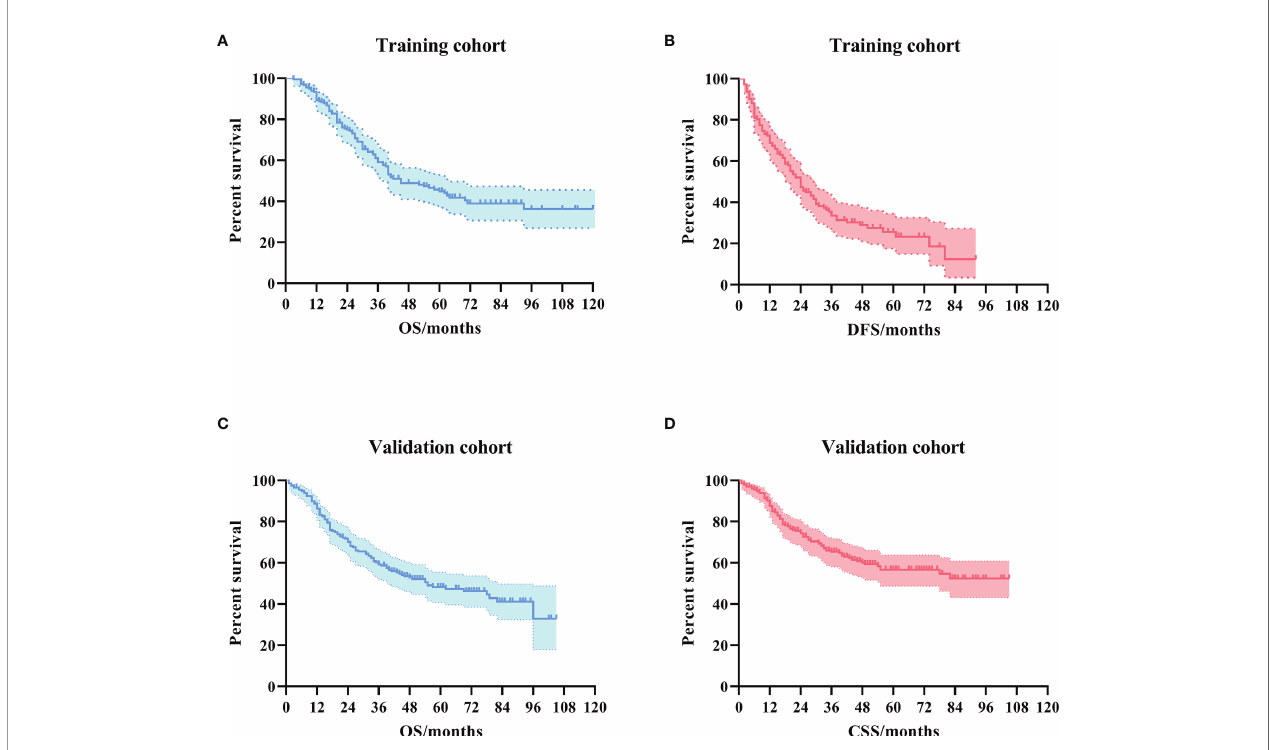
FIGURE 1 | The Kaplan – Meier survival curves for ampullary carcinoma patients after curative pancreaticoduodenectomy. (A) OS curve in the training cohort. (B) DFS curve in the training cohort. (C) OS curve in the validation cohort. (D) CSS curve in the validation cohort. OS, overall survival; DFS, disease-free survival; CSS, cancer-speci fi c